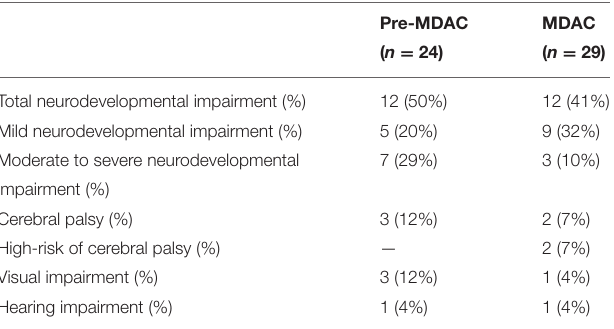
TABLE 2 | Neurodevelopmental outcomes during the pre-MDAC (2015–2017) and MDAC (2018–2020) epochs.